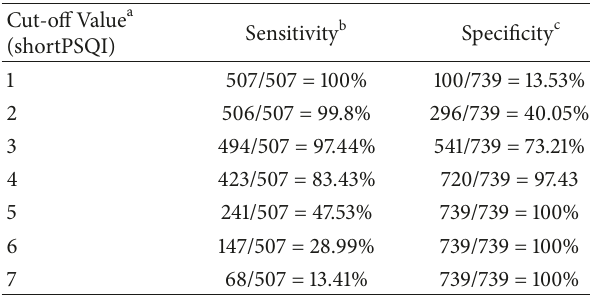
Table 3: Specificity and sensitivity of different cut-off values for “good” and “poor” sleeper scored by original and